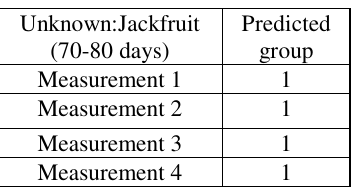
Fig.6. The construction of the classification model by CDA enable unknown maturity stage of jackfruit to be identified (with reference to